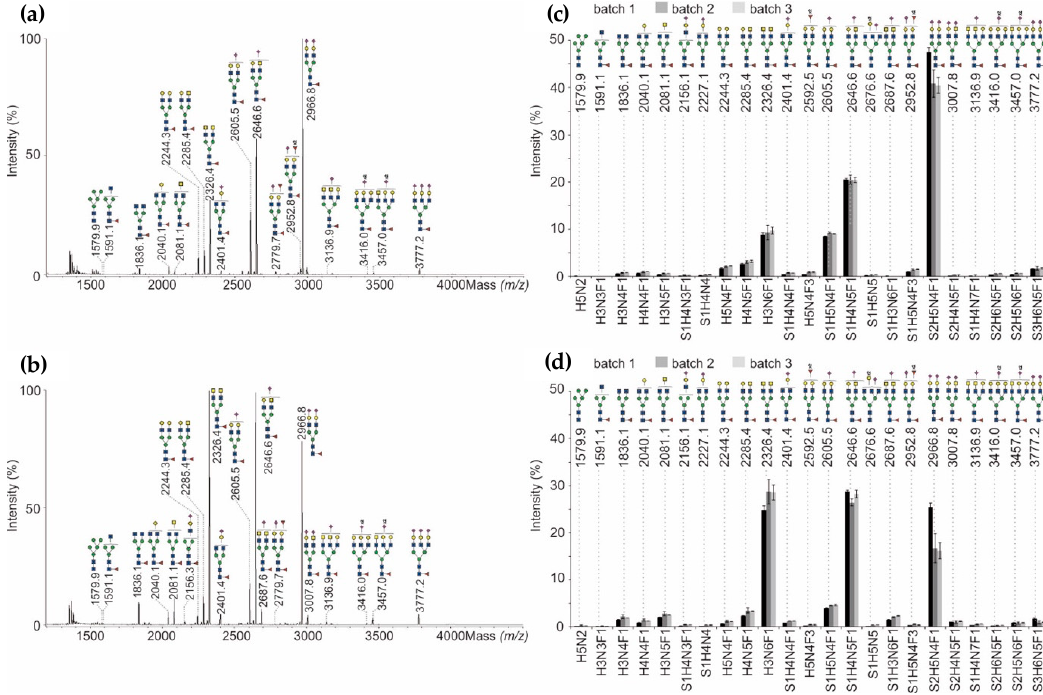
Figure 5. ( a ) MALDI-TOF-MS spectra of the most abundant permethylated N-glycans released from NovoSeven ® , and ( b ) AryoSeven™. ( c ) Relative abundance of permethylated N-glycans from three batches of NovoSeven ® , and ( d ) AryoSeven™ were calculated. Standard deviations were calculated from technical triplicates.